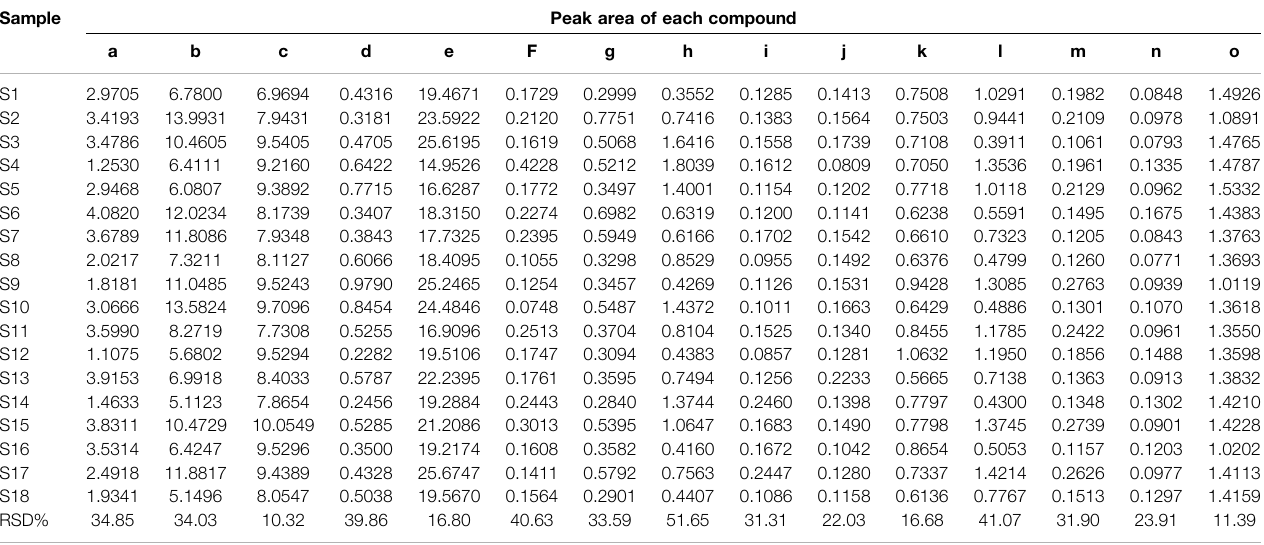
TABLE 1 | The relative peak area of 15 common peaks measured by UPLC-PDA. Sample Peak area of each